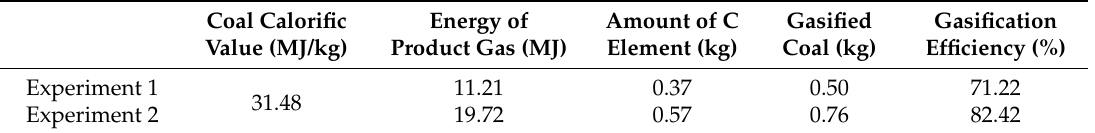
Table 4. Calculation of gasification efficiency (0.5~3.0 h for experiment 1, 0.5~1.5 h for experiment